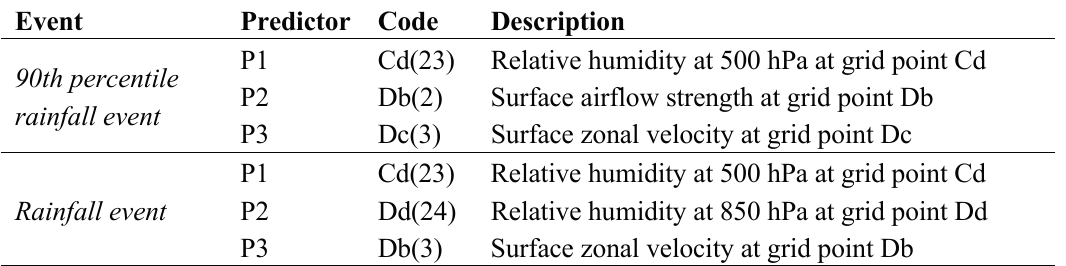
Table 3. NCEP variables used to build downscaled